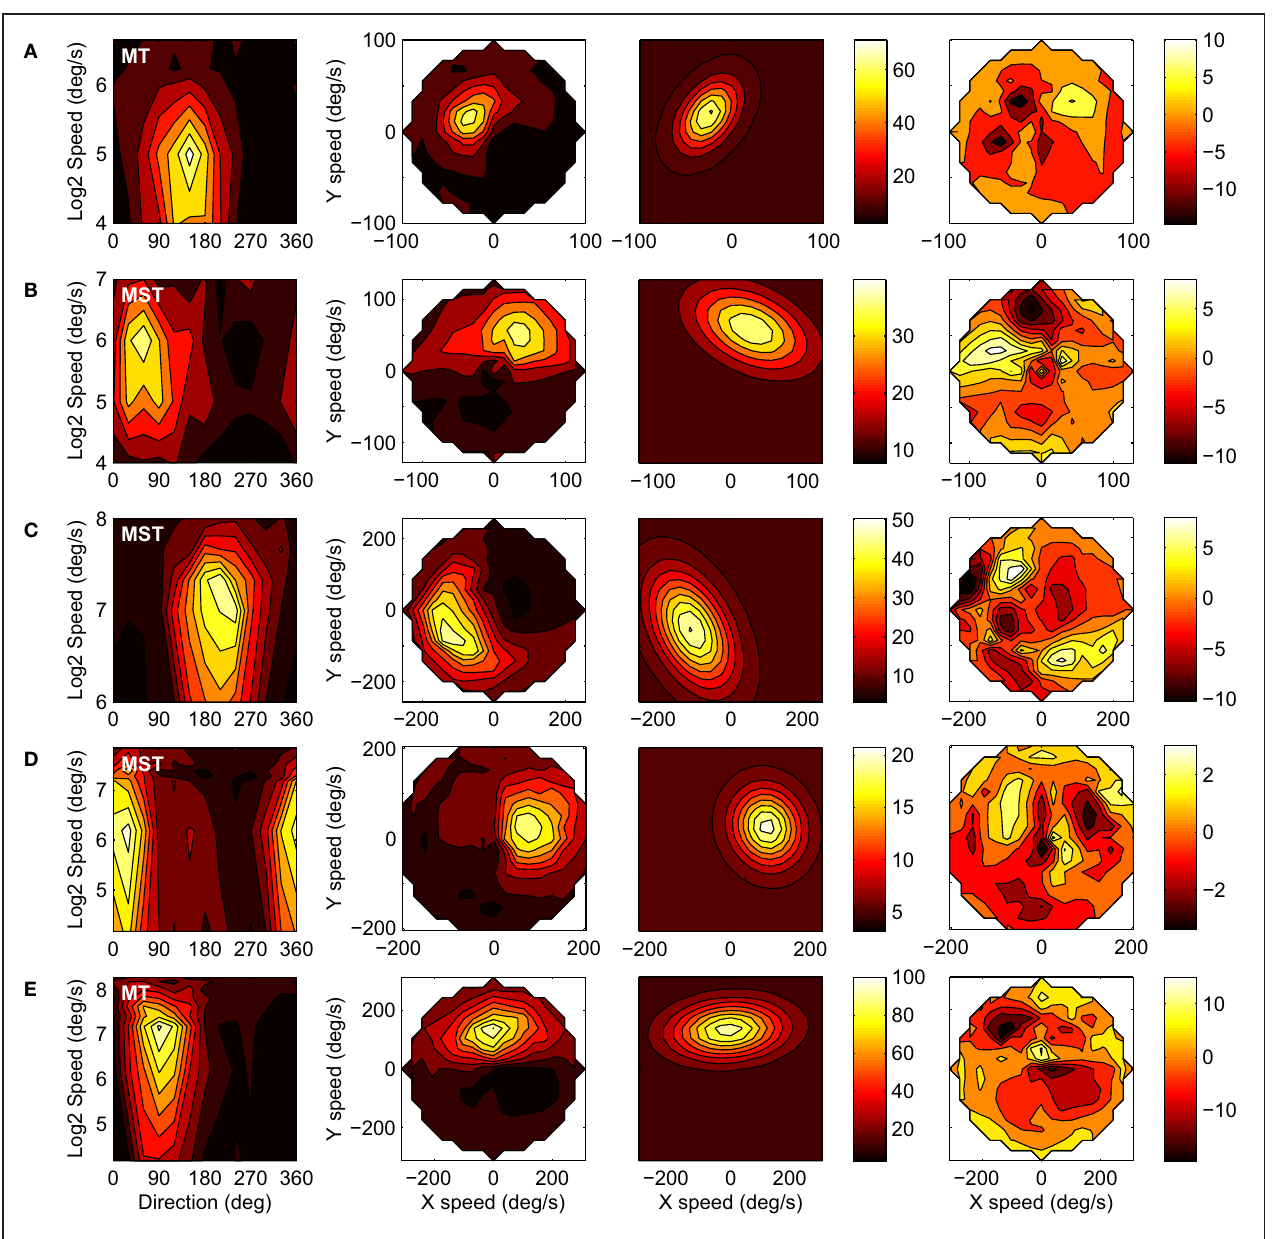
v = 31, w = 0 . 55, e = 1 . 6, a = 63, b = 8. (B) Monkey-A MST unit: r 2 = 0 . 73, d = 65, v = 66, w = 0 . 47, e = 1 . 8, a = 29, b = 11. (C) Monkey-F MST unit: r 2 = 0 . 89, d = 207, v = 121, w = 0 . 51, e = 1 . 8, a = 42, b = 8. (D) Monkey-F MST unit: r 2 = 0 . 83, d = 19, v = 97, w = 0 . 56, e = 1 . 2, a = 16, b = 5. (E) Monkey-F MT unit: r 2 = 0 . 88, d = 94, v = 132, w = 0 . 47, e = 2 . 0, a = 83, b = 12.